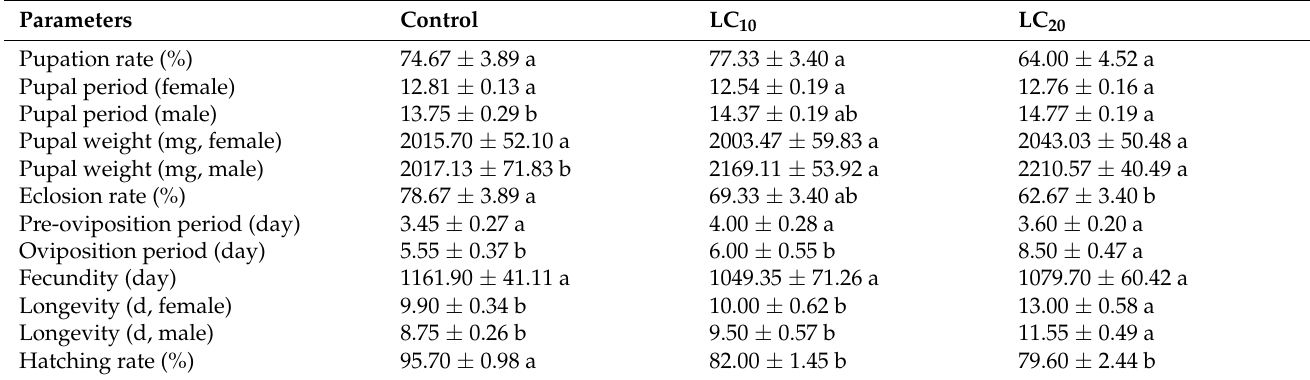
Table 3. Sublethal effects of EMB on the development time and reproduction parameters of the FAW parental generation.